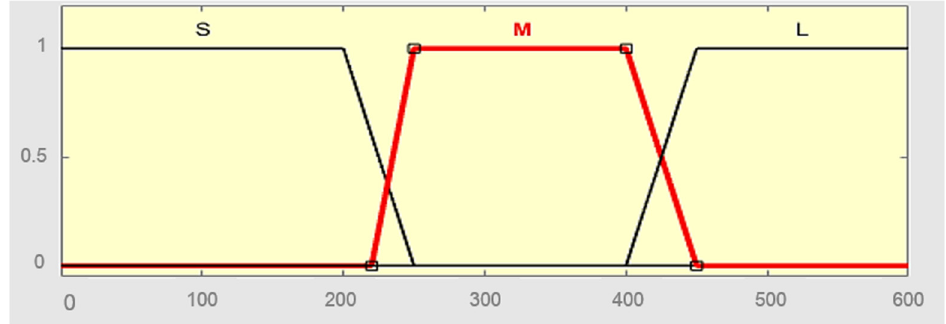
Figure 10. Membership functions of the latency variable for robust FLWADC.